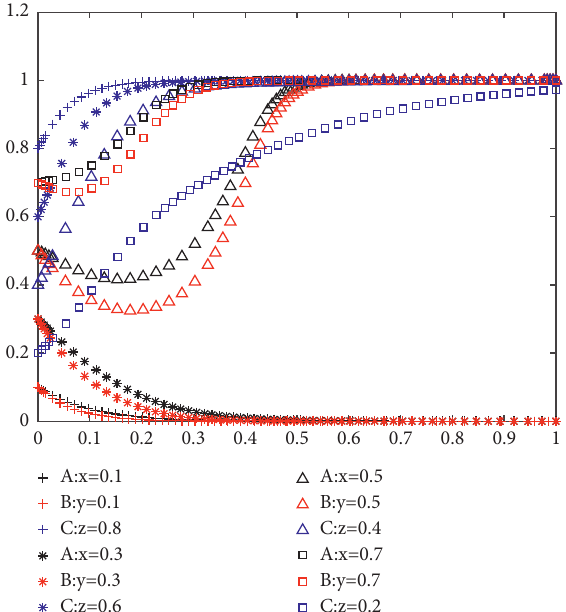
Figure 4: Evolutionary analysis of the initial willingness to participate in cooperation x and y simultaneously